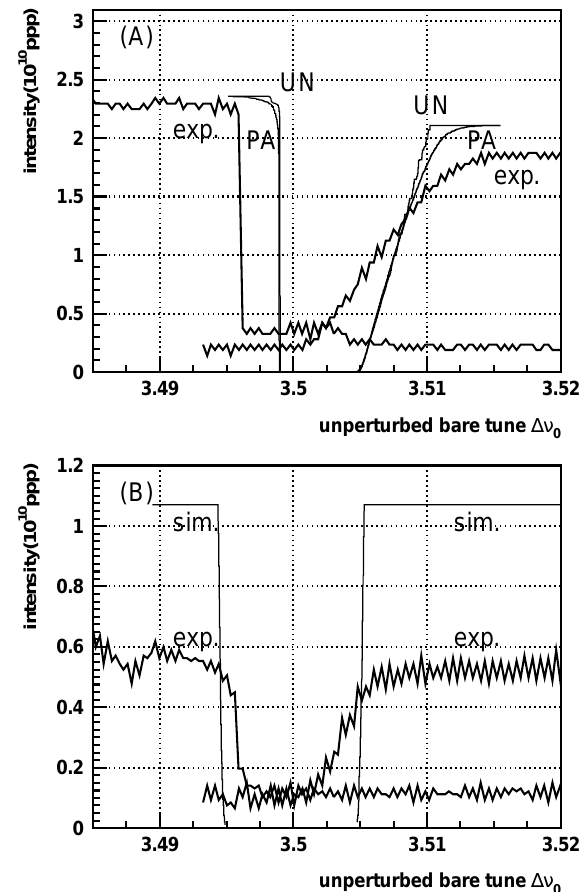
FIG. 12. Comparison of the beam loss waveform between the simulation (thin lines: UN for uniform beam and PA for para- bolic beam) and experimental results (thick jagged lines). In (A), the vertical axis for the simulation data is scaled so as to have the same coherent quadrupole mode tune, using Dn q (cid:1) 2 (cid:1) 0.0028 (cid:1) 10 10 ppp, while it is arbitrary in